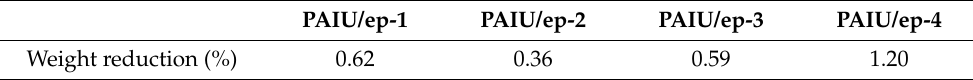
Table 4. Chemical resistance test results of PAIU/epoxy IPNs.